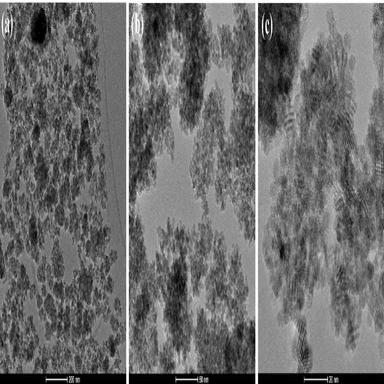
HR-TEM (a–c) and HR-TEM/EDS (d–g) images of CuFe2O4. (A colour version of this figure can be viewed online.)